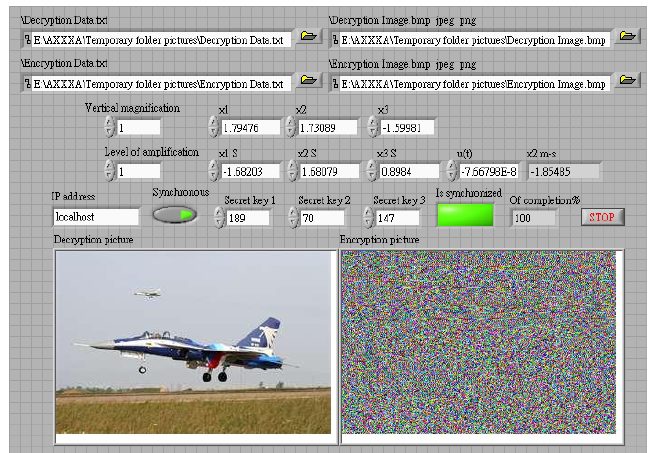
Figure 5. Reception control